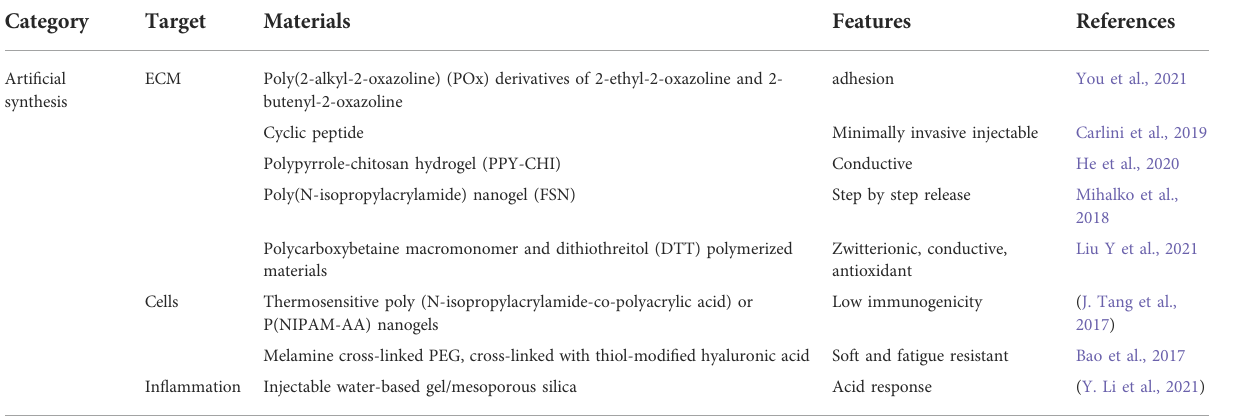
TABLE 2 Synthetic